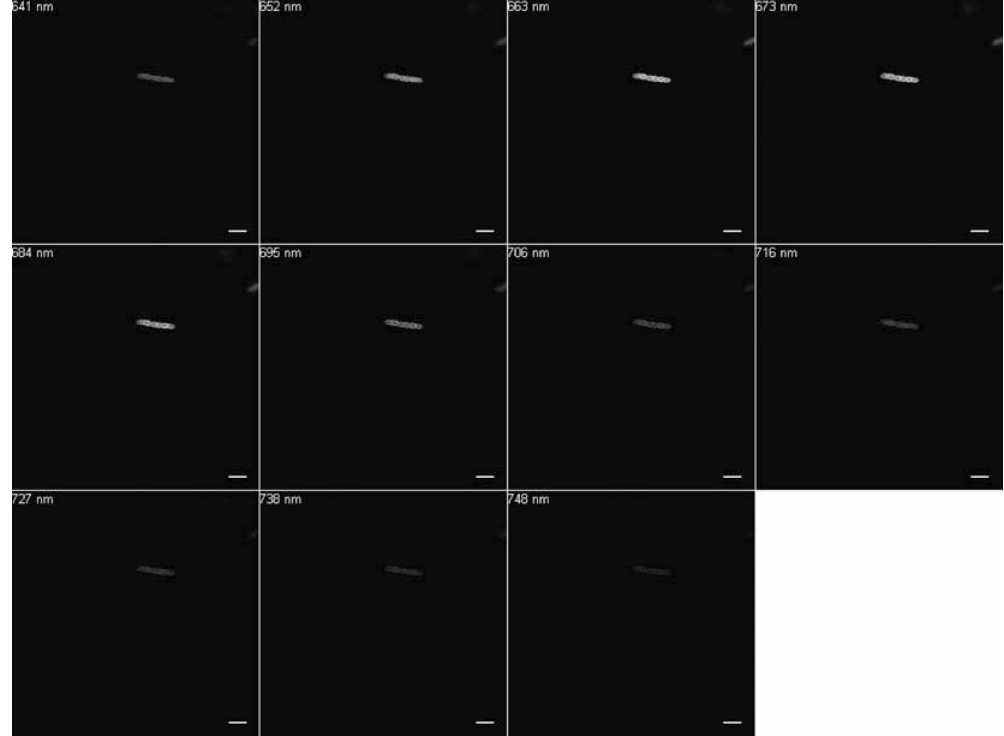
Figure 7. Spectral emission collection of SF33 GL-grown cells after excitation with 633-nm laser. An emission spectrum was gathered at 10.7-nm increments in the range from 640 nm to 750 nm all images at 63× oil objective. Bars, 10 μm.